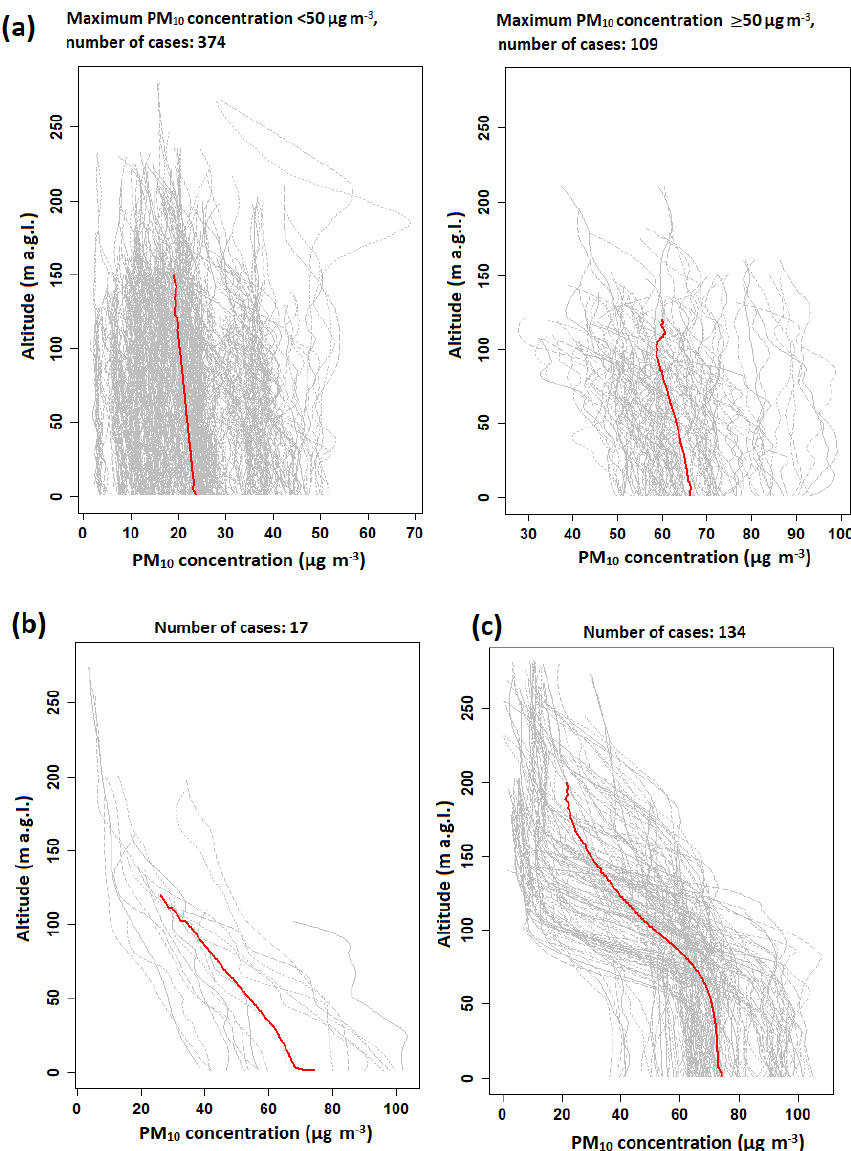
Figure 5. Classification of PM 10 vertical profiles into the three main types: (a) type I (it is presented in two plots due to a wide range of PM 10 concentration values); (b) type II; (c) type III. Explanations: grey lines – individual vertical profiles of PM 10 concentration; red lines – mean profiles of a certain